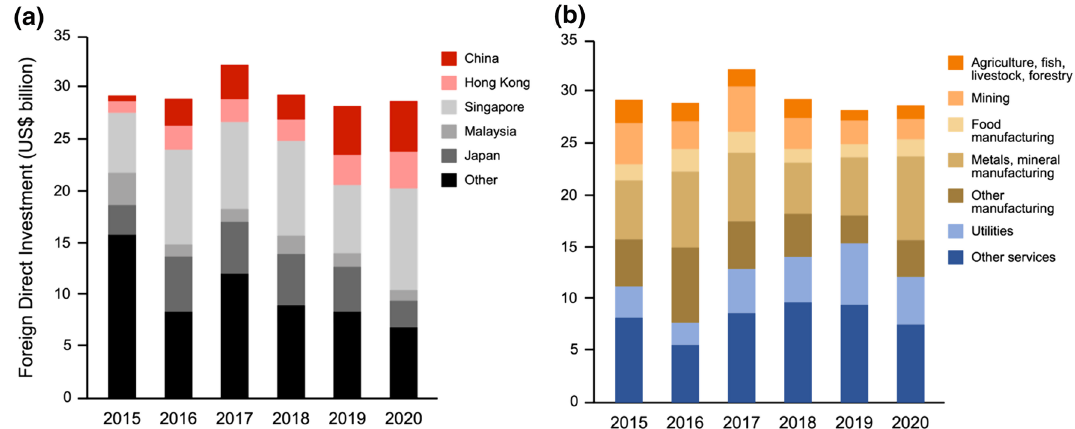
Fig. 1 a Annual trends in the top five countries contributing to foreign direct investment (FDI) in Indonesia since 2015. b Annual trends in total FDI in Indonesia across sectors since 2015. Data from BKPM